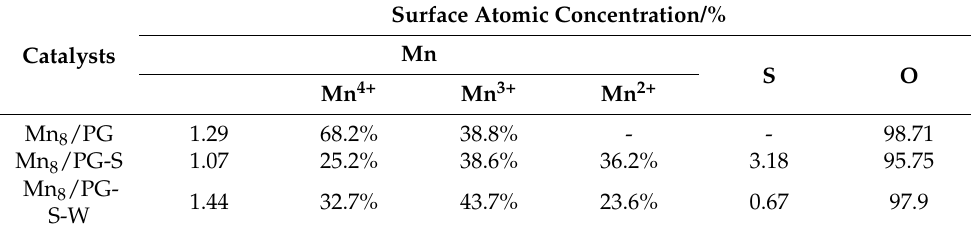
Table 4. XPS results for surface Mn atomic